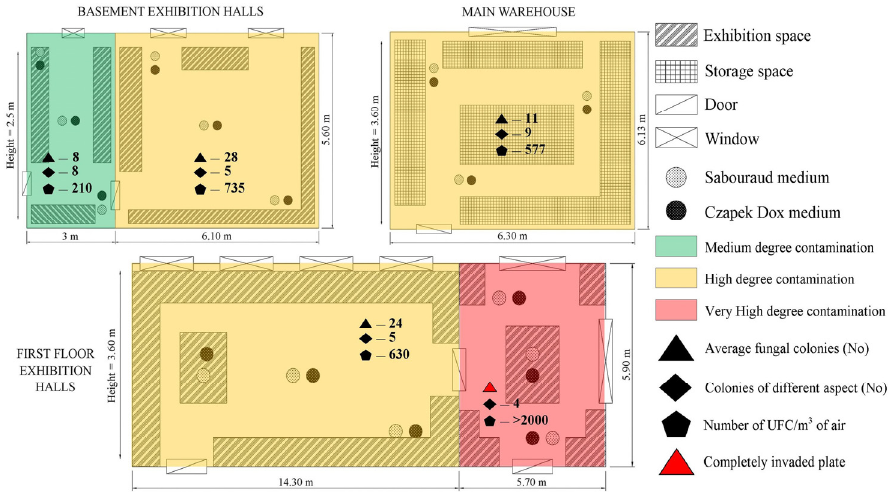
Figure 2. Degree of fungal contamination in the air of the analysed rooms (processing after Ilie ș et al. [49]) . et al.